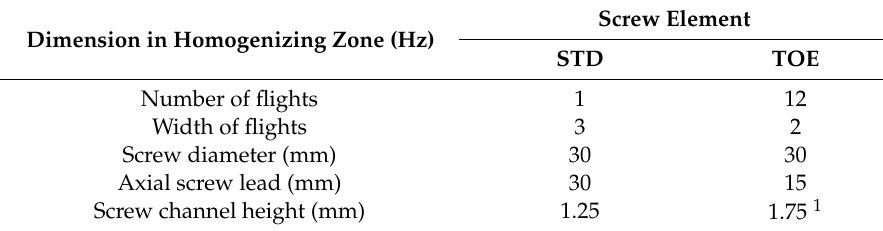
Figure 2. Modular screws employed in the experiments: ( a ) Arrangement of screw elements; ( b ) Standard elements (STDs); ( c ) Torsion elements (TOEs). Table 2. Geometric parameters of the screw elements.